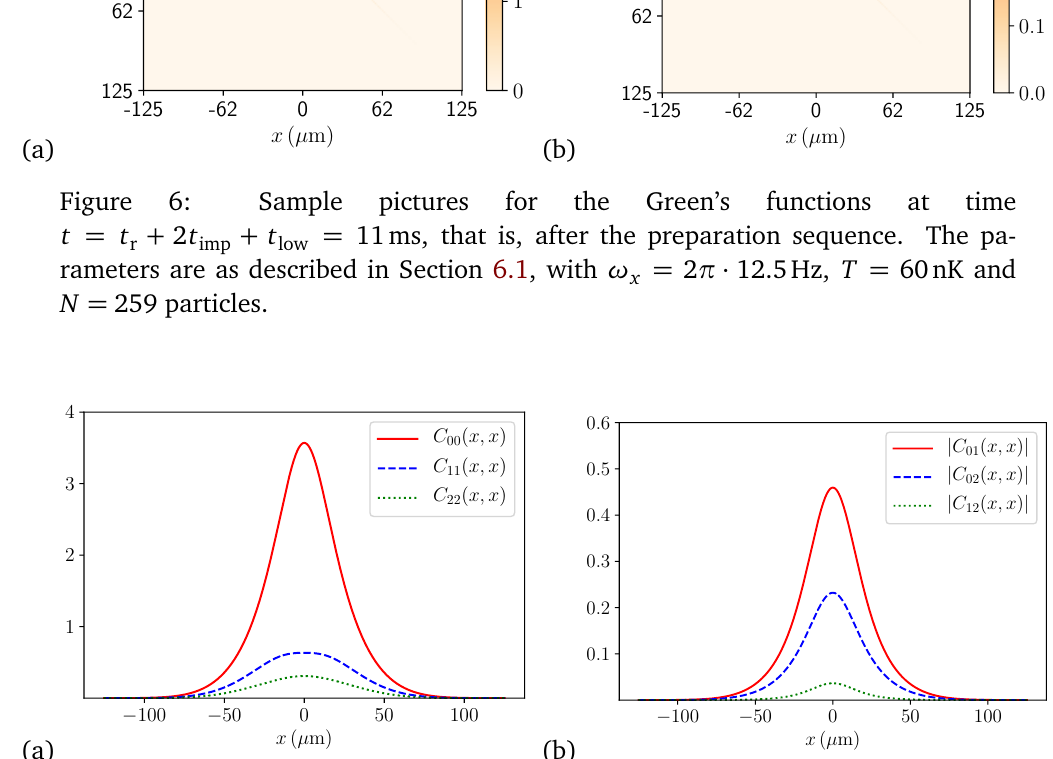
Figure 7: The spatial diagonal of Green’s functions C same parameters as in Fig. 6.